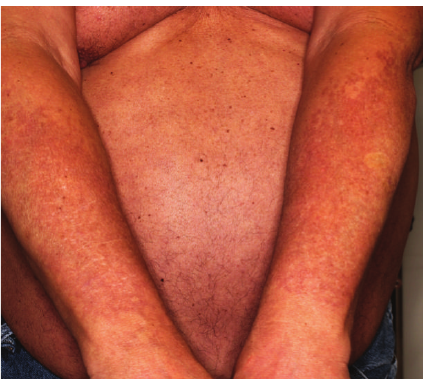
Figure 1: Clinical presentation of acquired brachial cutaneous dyschromatosis. There are irregular hyper- and hypopigmented macules coalescing into large patches on the bilateral dorsal fore- arms.